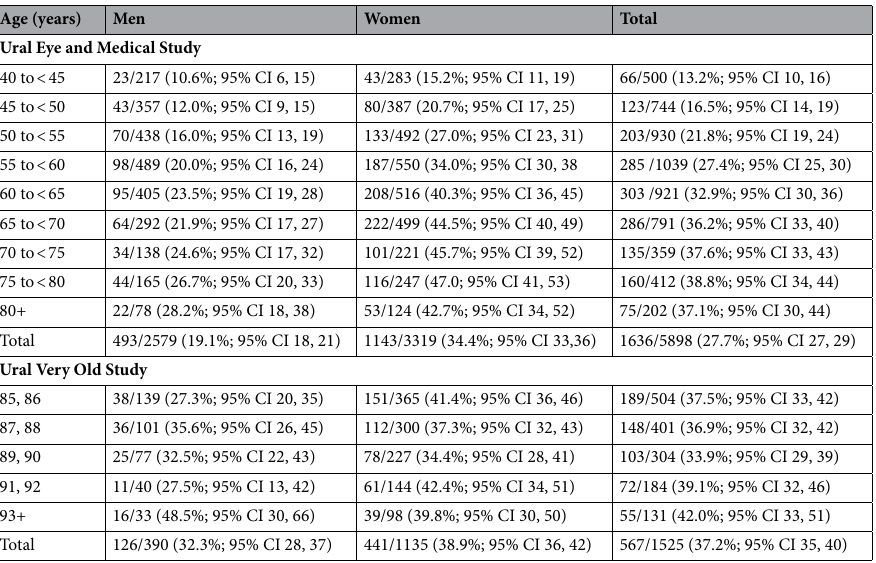
Table 1. Prevalence of osteoarthritis in the Ural Eye and Medical Study and Ural Very Old Study, stratified by age and